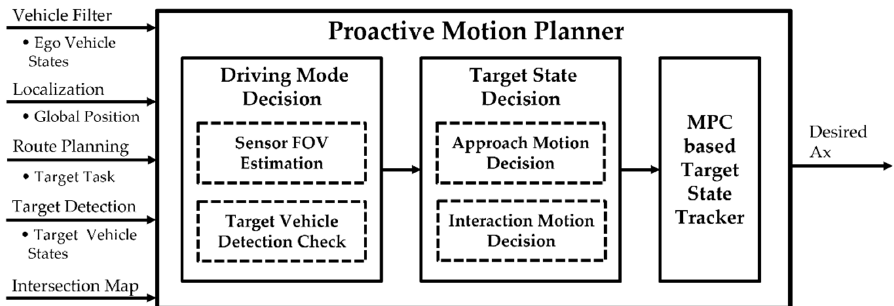
Figure 1. The overall architecture of the proactive motion planner for uncontrolled blind intersections.